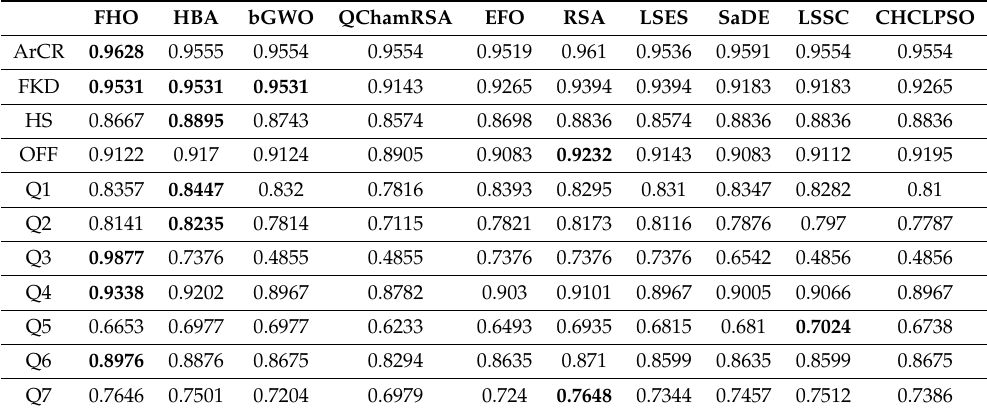
Table 5. Precision results obtained by FHO and other methods in the binary case.